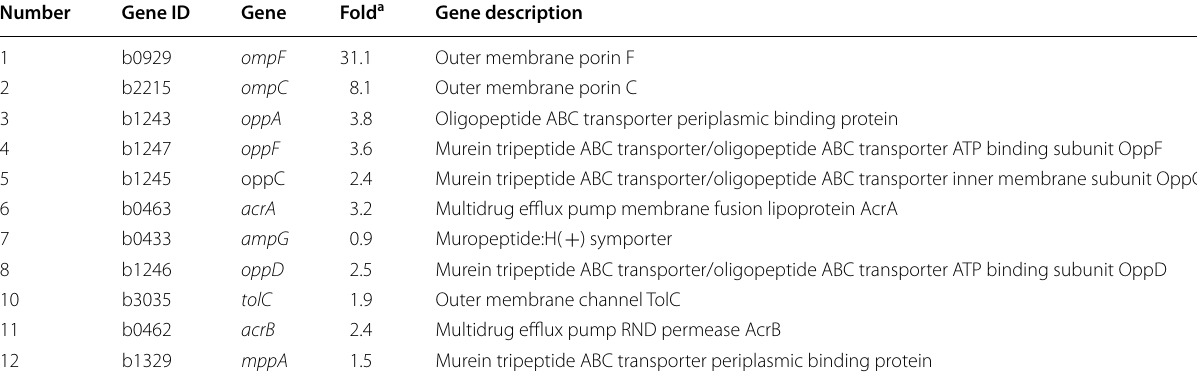
a Down-regulated